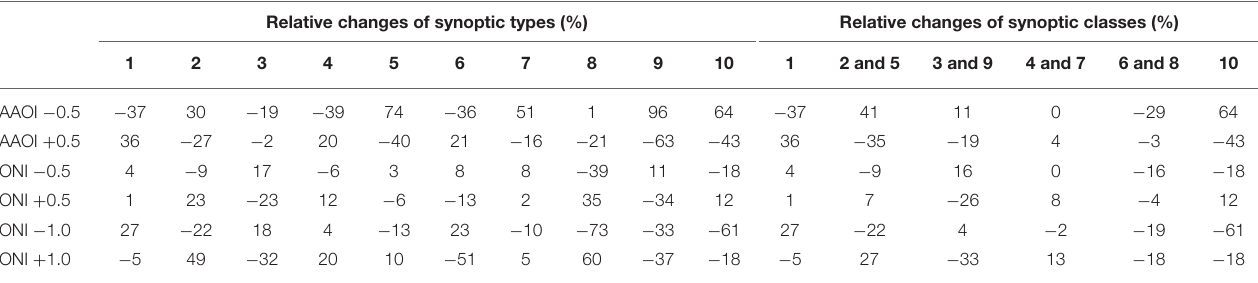
TABLE 9 | Relative changes ( % ) of synoptic types and classes during positive and negative AAO and ENSO events between 2000 and 2016. Relative changes of synoptic types (%) Relative changes of synoptic classes